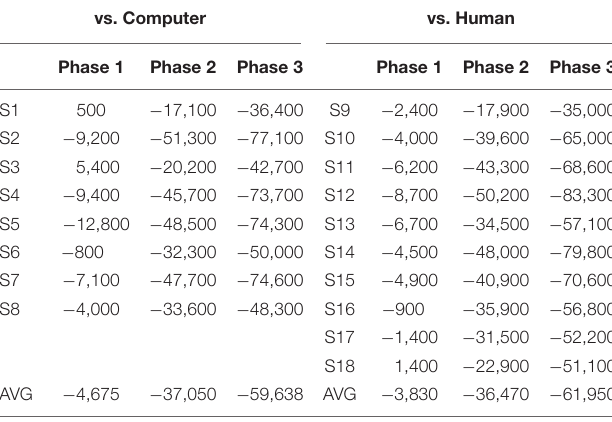
TABLE 3 | The scores earned by each participant (S1 – S18) after the last iteration of each phase. vs. Computer